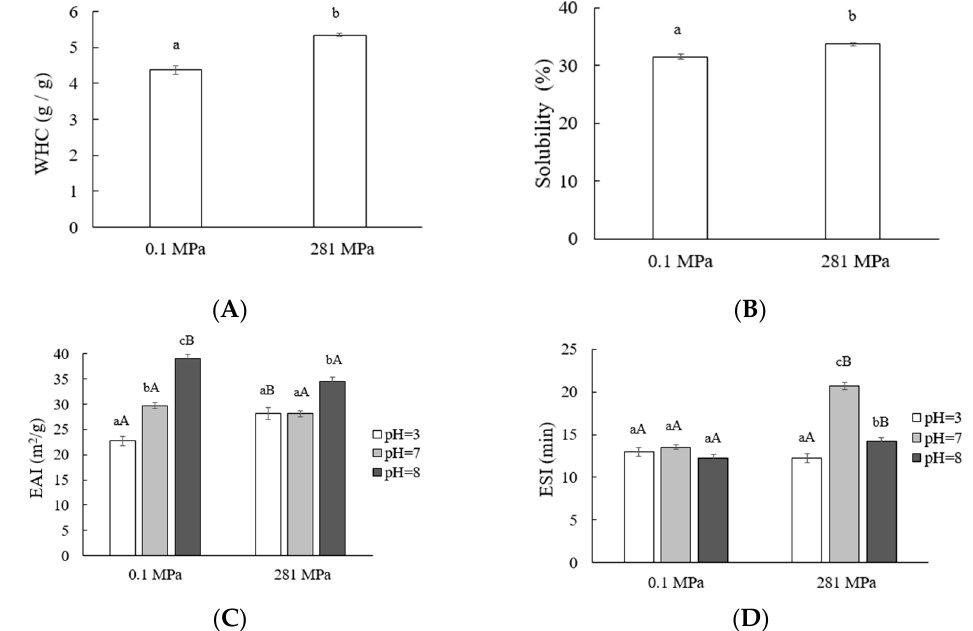
Figure 3. Functional properties of SPI (0.1 MPa) and HHP-SPI (281 MPa) soybean proteins: water holding capacity ( A ), solubility ( B ), emulsifying activity ( C ), and emulsifying stability ( D ). Capital letters: statistical significance between groups; lowercase letters: statistical significance in the groups.